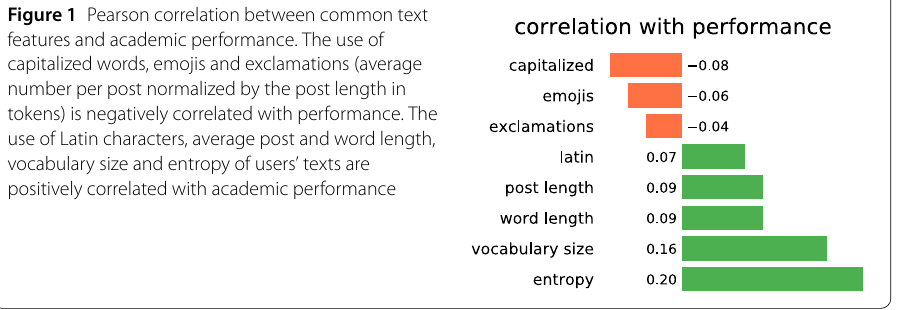
Figure 1 Pearson correlation between common text features and academic performance. The use of capitalized words, emojis and exclamations (average number per post normalized by the post length in tokens) is negatively correlated with performance. The use of Latin characters, average post and word